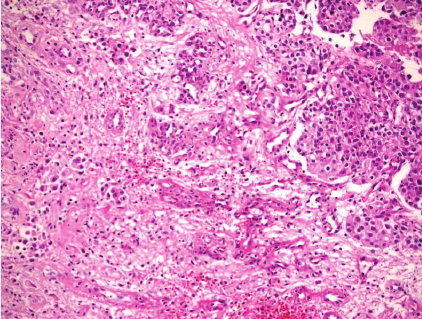
Figure 3: Epithelial tumour infiltration in neuroglial tissue (hema- toxylin and eosin, × 200).